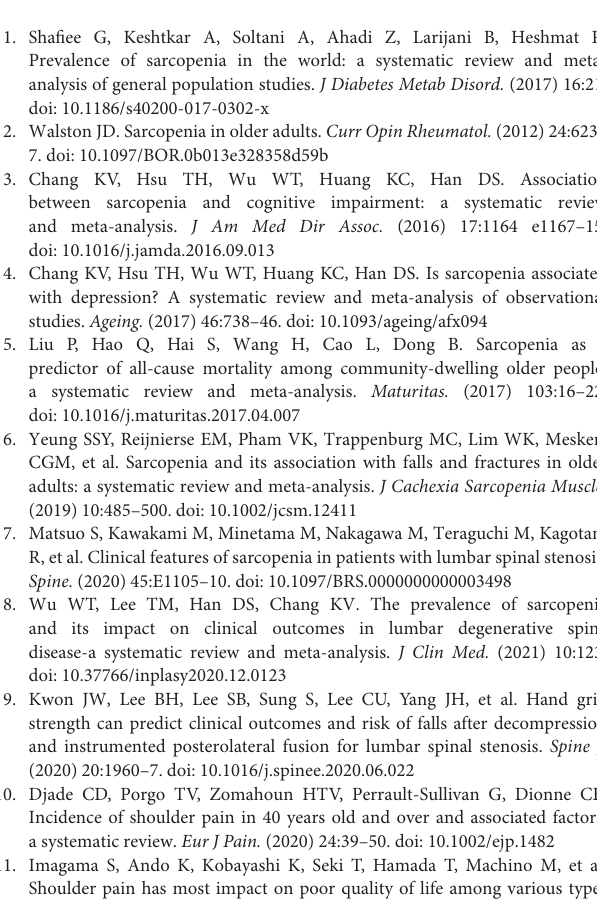
Supplementary Figure 2 | Correlation of tendon thickness with grip strength (A) and skeletal muscle mass index (B) , ER TM with grip strength (C) and skeletal muscle mass index (D) and ER TT with grip strength (E) and skeletal muscle mass index (F) of the biceps long head tendons. The regression line is plotted on when p -value is < 0.05. The heat map with background color coding suggests clusters of observations. ER TM , echogenicity ratio of the tendon vs. the overlying deltoid muscle; ER TT , echogenicity ratio of the tendon vs. the overlying subcutaneous tissue. Supplementary Figure 3 | Correlation of tendon thickness with grip strength (A) and skeletal muscle mass index (B) , ER TM with grip strength (C) and skeletal muscle mass index (D) and ER TT with grip strength (E) and skeletal muscle mass index (F) of the subscapularis tendons. The regression line is plotted on when p value is < 0.05. The heat map with background color coding suggests clusters of observations. ER TM , echogenicity ratio of the tendon vs. the overlying deltoid muscle; ER TT , echogenicity ratio of the tendon vs. the overlying subcutaneous tissue. Supplementary Figure 4 | Correlation of tendon thickness with grip strength (A) and skeletal muscle mass index (B) , ER TM with grip strength (C) and skeletal muscle mass index (D) and ER TT with grip strength (E) and skeletal muscle mass index (F) of the infraspinatus tendons. The regression line is plotted on when p -value is < 0.05. The heat map with background color coding suggests clusters of observations. ER TM , echogenicity ratio of the tendon vs. the overlying deltoid muscle; ER TT , echogenicity ratio of the tendon vs. the overlying subcutaneous